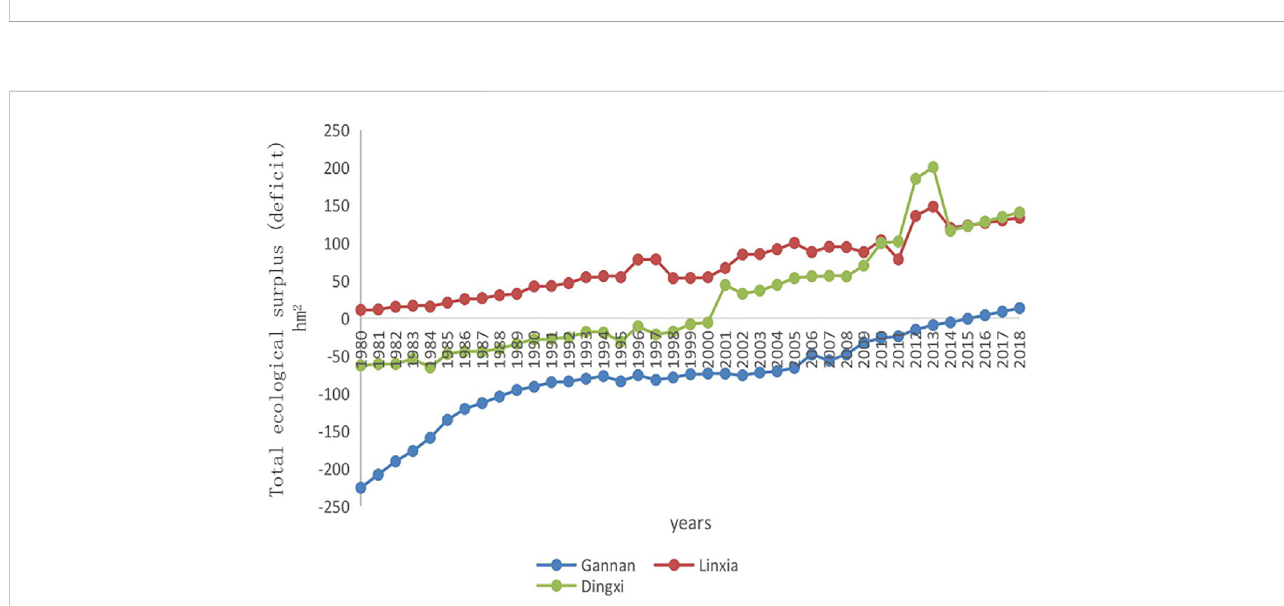
FIGURE 5 Comparison of the total ecological surplus of the three regions from 1980 to